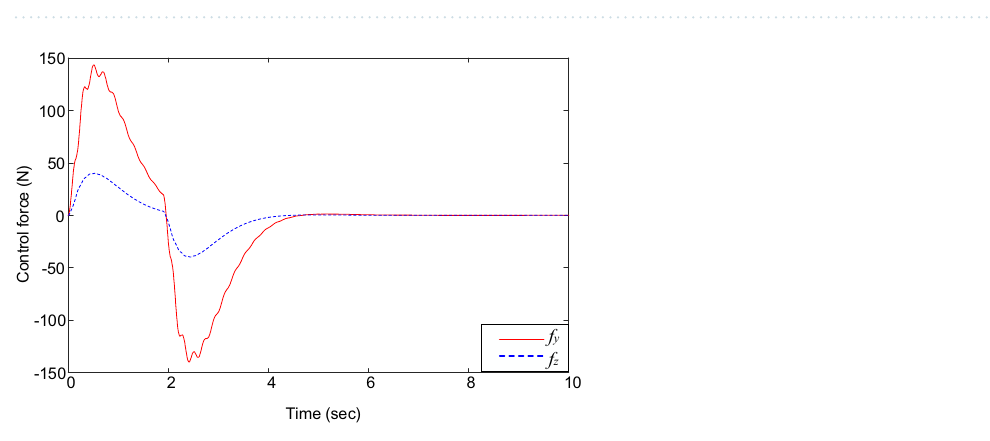
Figure 3. Vibrations of the beam’s tip: ( a ) Transverse vibration w ( l , t ), ( b ) lateral vibration v ( l , t ), and ( c ) longitudinal vibration u ( l , t ).